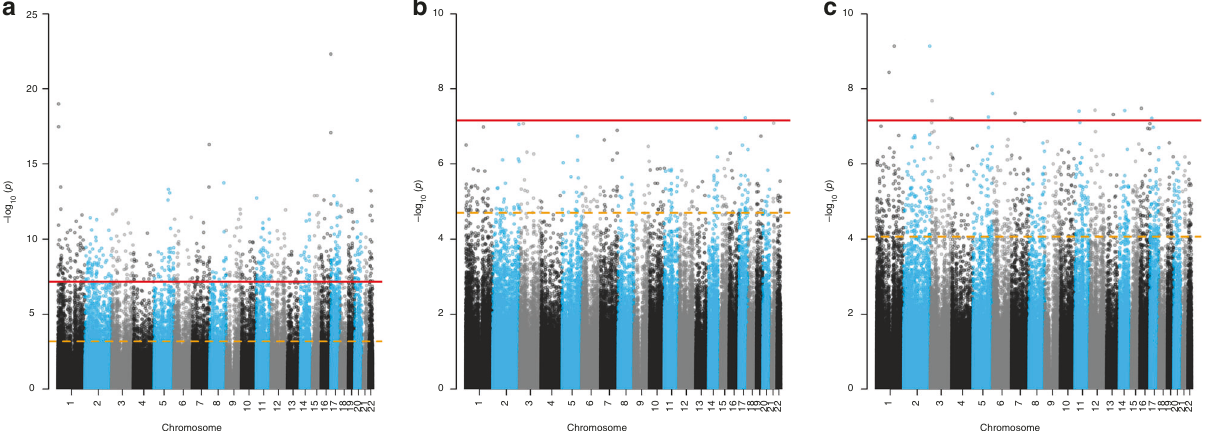
Fig. 2 Nasal epigenome-wide associations for fractional exhaled nitric oxide (FeNO), asthma, and allergic asthma. Uncorrected − log 10 ( P values) plotted in the y -axis for each CpG site and sorted by chromosomal and genomic position on the x -axis. Adjustment for multiple testing was accounted for each epigenome-wide association analyses by controlling the false discovery rate (FDR <0.05), horizontal orange dashed line, and Bonferroni threshold for statistical signi fi cance ( P < 6.95 × 10 − 8 ) shown in the solid red horizontal line. a Manhattan plot of epigenome-wide association analyses (EWAS) for fractional exhaled nitric oxide (FeNO), b Manhattan plot of EWAS for current asthma, and c Manhattan plot of EWAS for current allergic asthma Table 3 Top 20 differentially methylated CpGs associated with current asthma compared to never reporting asthma CpG